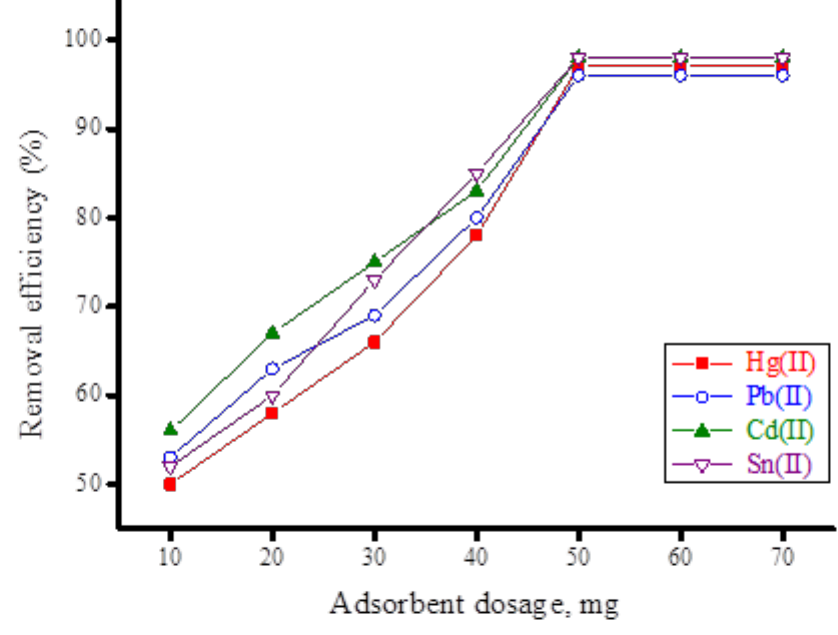
Figure 11. Removal efficiency (%) of heavy metal ions (20 mg/100 mL) using different amounts of synthesized ZnF 2 O 4 -CNT adsorbent material.